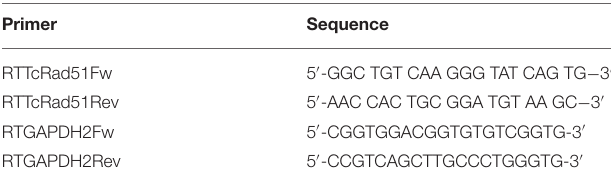
TABLE 1 | Primers used on Real-time PCR